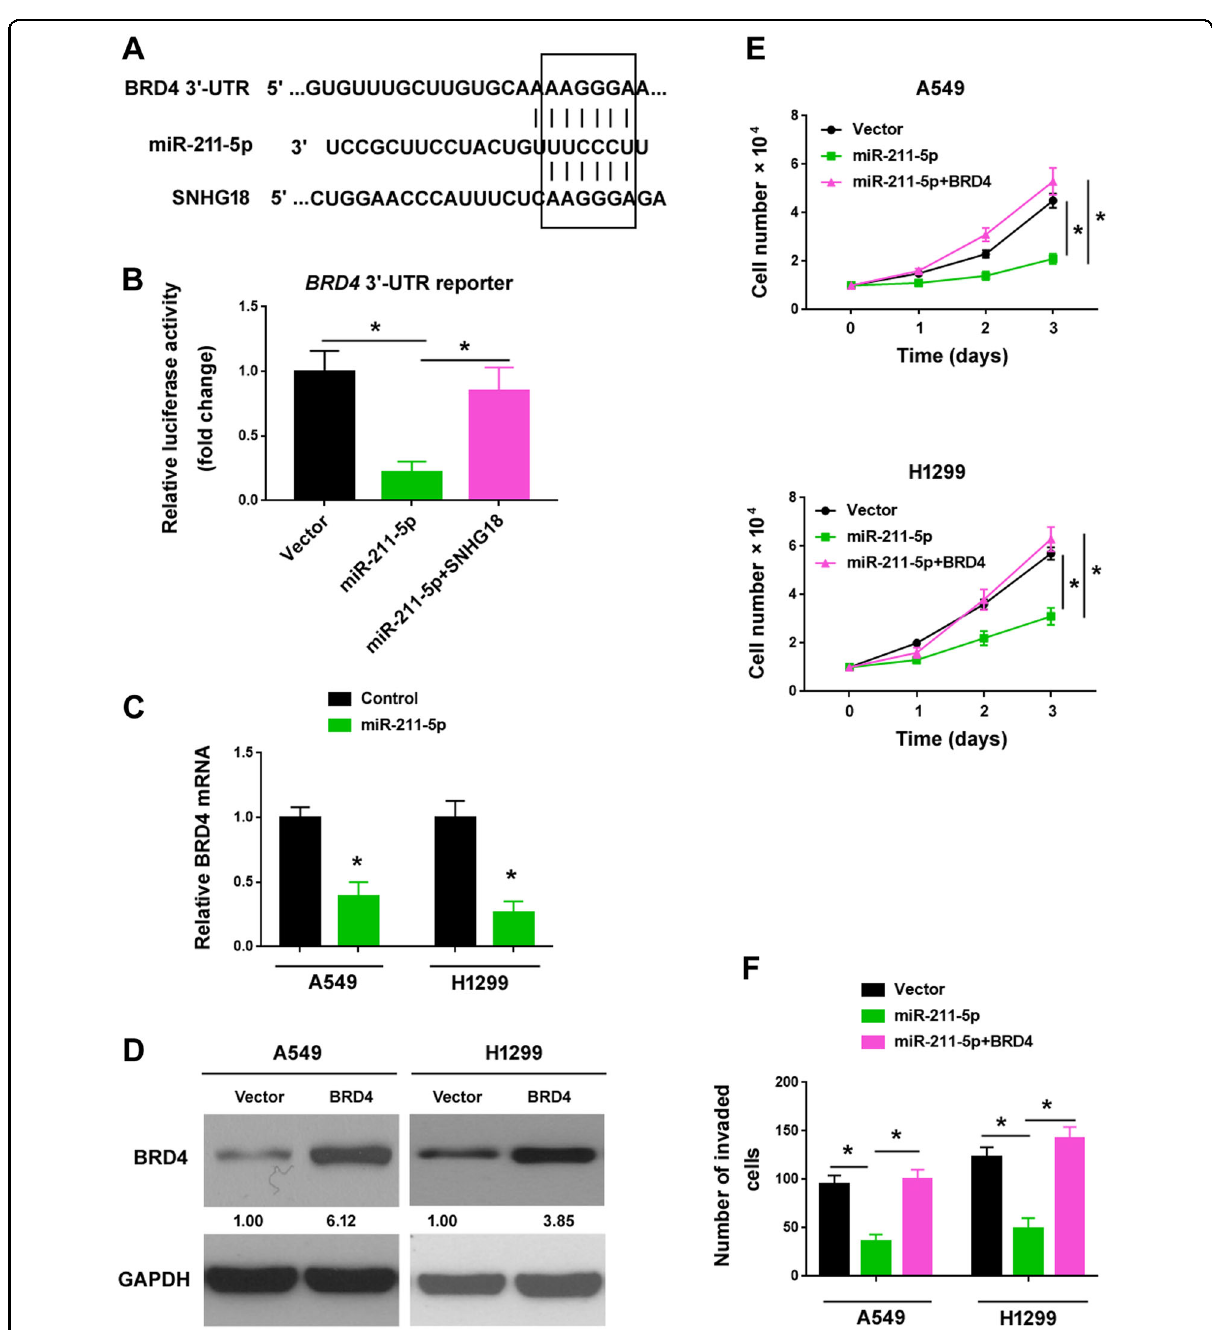
Fig. 7 BRD4 serves as a functional target of miR-211-5p. A Bioinformatic analysis indicated the potential target sites for miR-211-5p in BRD4 and SNHG18. B Luciferase reporter assay showed that miR-211-5p repressed the expression of the BRD4 3 ’ -UTR reporter. Overexpression of SNHG18 rescued miR-211-5p-mediated repression of BRD4 3 ’ -UTR reporter. n = 3. C Quantitative PCR analysis of BRD4 mRNA in A549 and H1299 cells transfected with control mimic or miR-211-5p mimic. * P < 0.05 vs. control mimic, Student ’ s t -test. n = 3. D Western blot analysis of BRD4 protein expression in NSCLC cells transfected with empty vector or BRD4-expressing vector. E , F Assessment of E cell proliferation and F invasion in NSCLC cells transfected with indicated constructs. * P < 0.05. n = 3. In all panels in this fi gure, one-way ANOVA and Bonferroni ’ s tests were performed unless otherwise